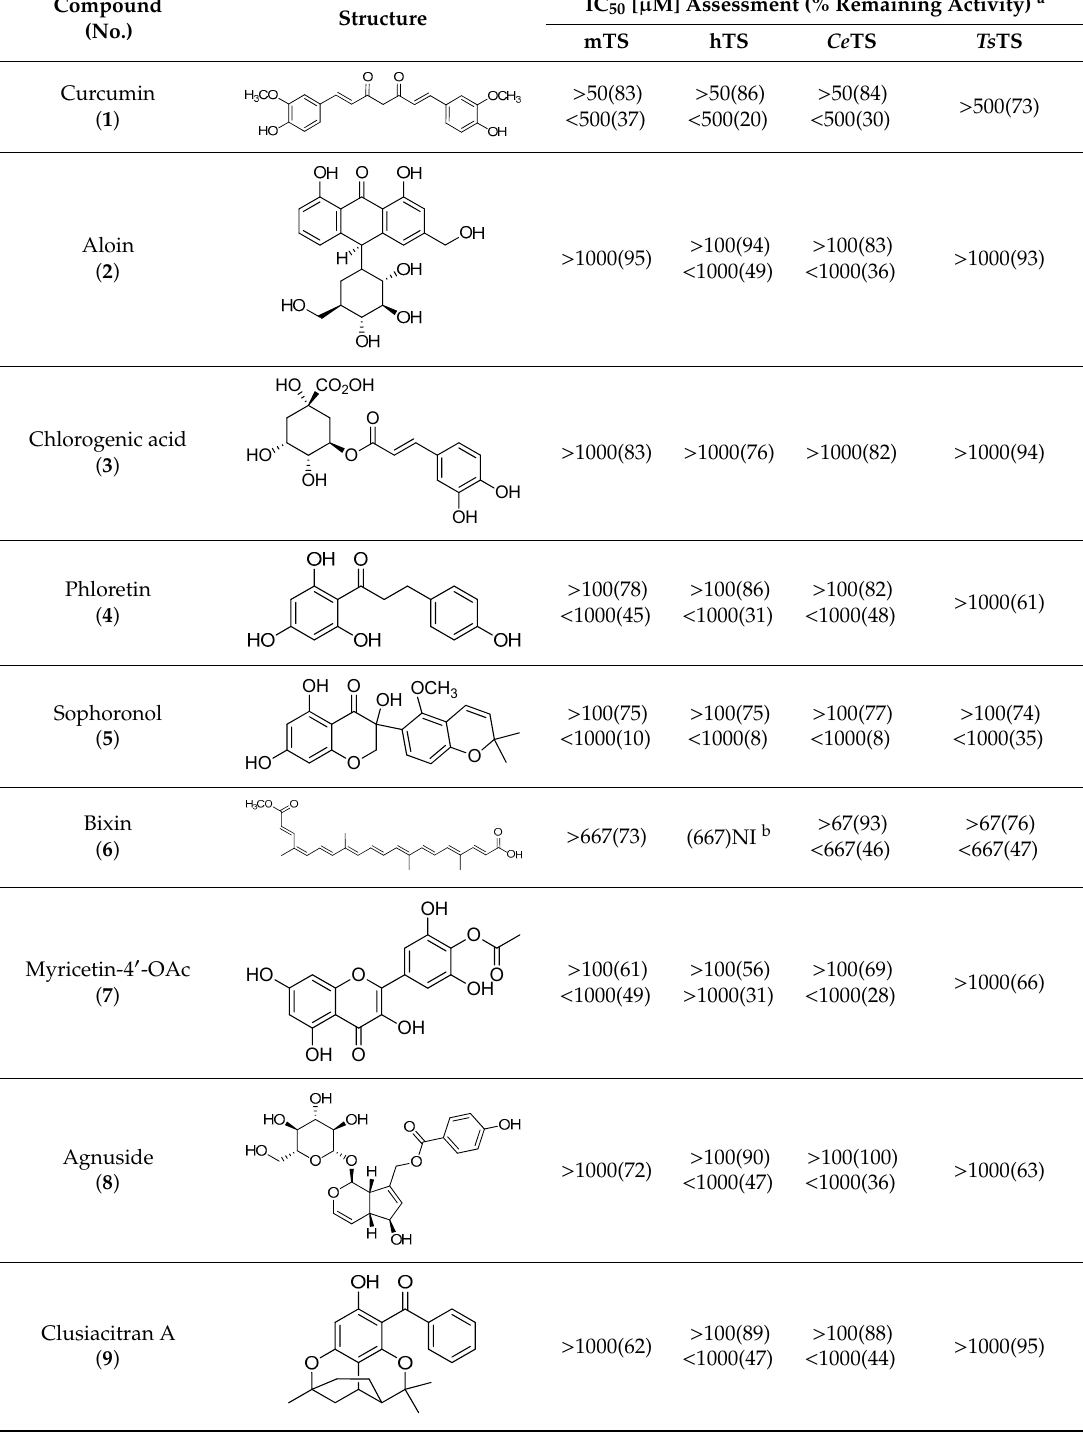
Table 1. Assessment of the IC 50 values describing inhibition of thymidylate synthases (TSs) of different origin by compounds selected by the 3D structure-based virtual search of the in-house library of natural compounds (Table 1, compounds 1 – 20 ) and obtained from that library, and by α -mangostin (Table 1, compound 21 ), a close structural analogue of alvaxanthone, included in the study after learning inhibitory properties of the latter and purchased from a commercial source.